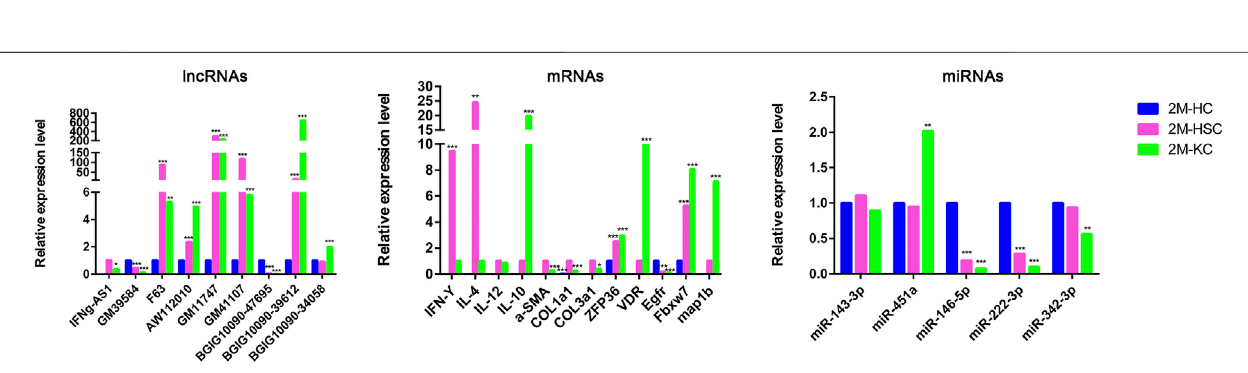
FIGURE7| TherelativeexpressionlevelofDElncRNAs,DEmRNAs,andDEmiRNAsindifferentcellsat2mp.i..SkybluerepresentstheexpressionofgenesinHCs, red and purple represents HSCs and KCs, respectively.